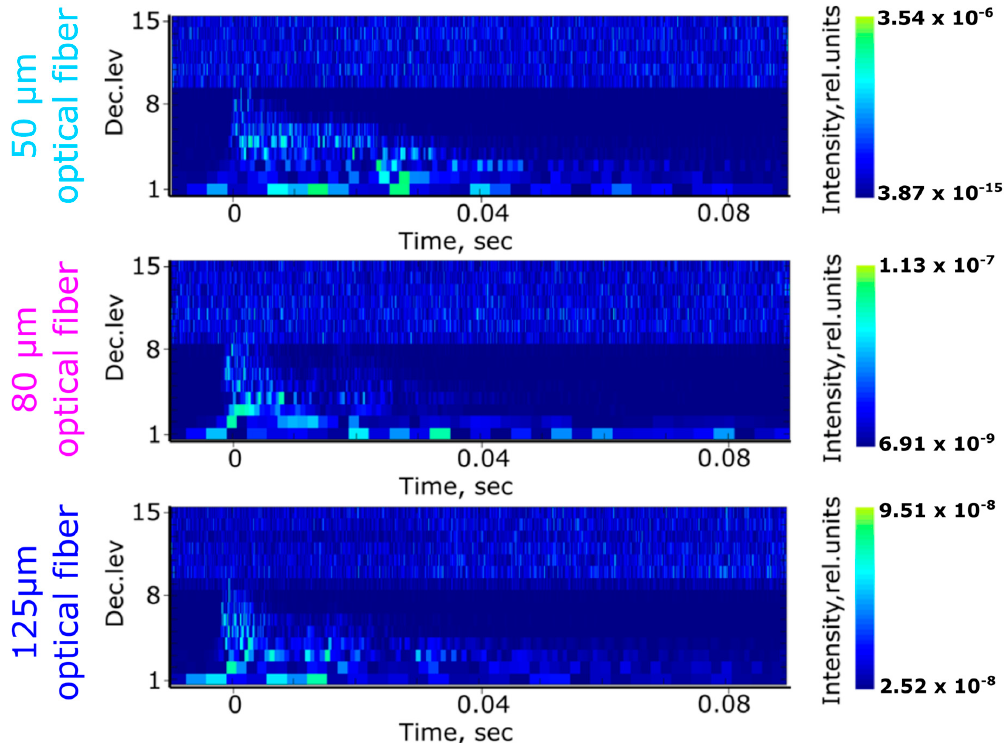
Figure 5. Spectrograms acquired using discrete wavelet packet transform for the three different-diameter optical fiber FBG sensors.